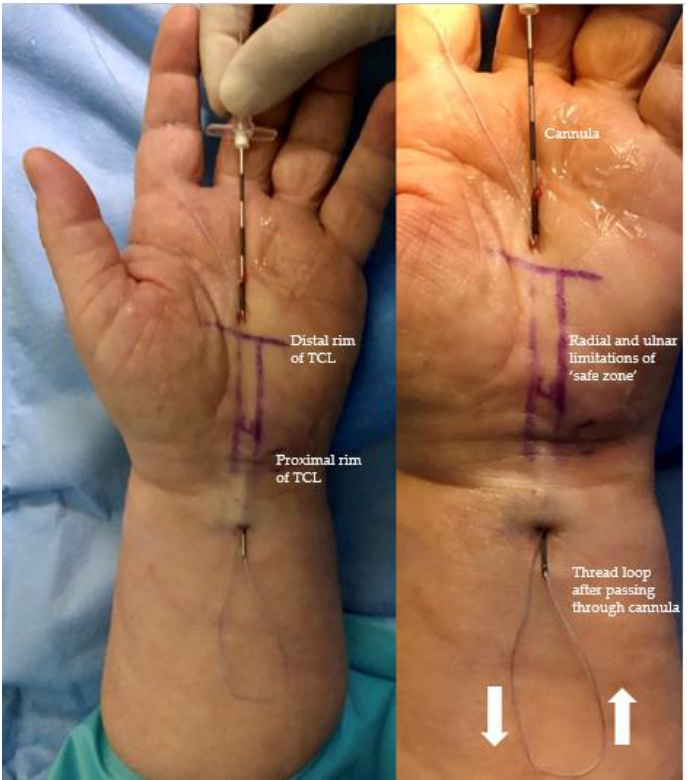
Figure 3. Surgical site after the second pass of the 18 G cannula under the superficial palmar aponeurosis and looping of the thread, including anatomical landmarks and the direction of passage of the